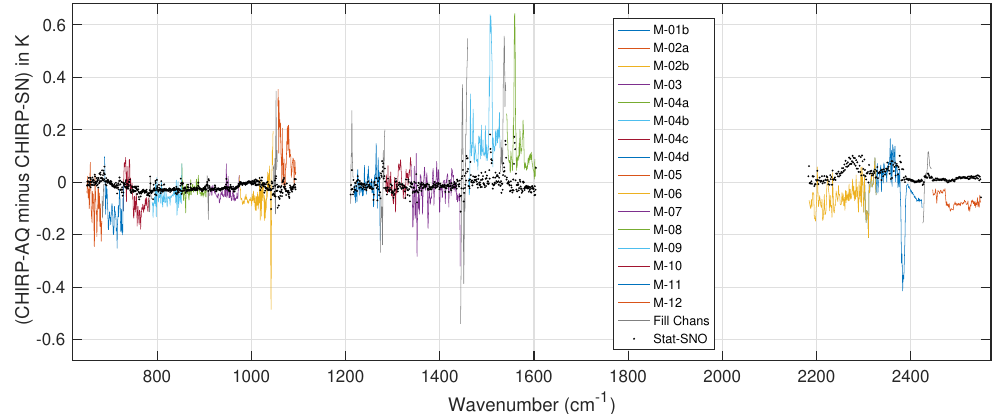
Figure 8. BT bias between AIRS and SNPP-CrIS, both converted to the CHIRP spectral response. The colors denote the locations of different AIRS detector modules that contribute to CHIRP. These biases were derived from the 2018, 1 percent random subset of AIRS and SNPP-CrIS radiance, with a small correction for differences in the mean secant angle for each instrument (see text). The black dots represent the difference between these biases, and biases derived from the AIRS and SNPP-CrIS SNOs. Biases derived from both techniques are very similar with a mean difference of